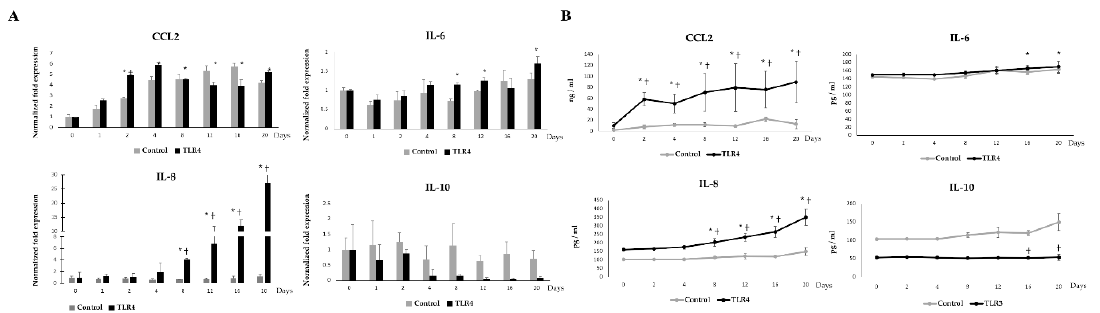
Figure 9. TLR4 mediated adipokine production in adipocytes. The figure displayed the TLR4 mediated mRNA expression ( A ) and protein concentration ( B ) of CCL2, IL-6, IL-8, IL-10 in the adipocytes at different time points of 20 days of adipogenesis. Data shown are the mean ± SD of three independent experiments performed in triplicates. The ‘*’ indicate d statistical differences when compared with day 0, and ‘†’ indicated statistical differences when compared with control group at the same time point, both at the significance level of p < 0.05.